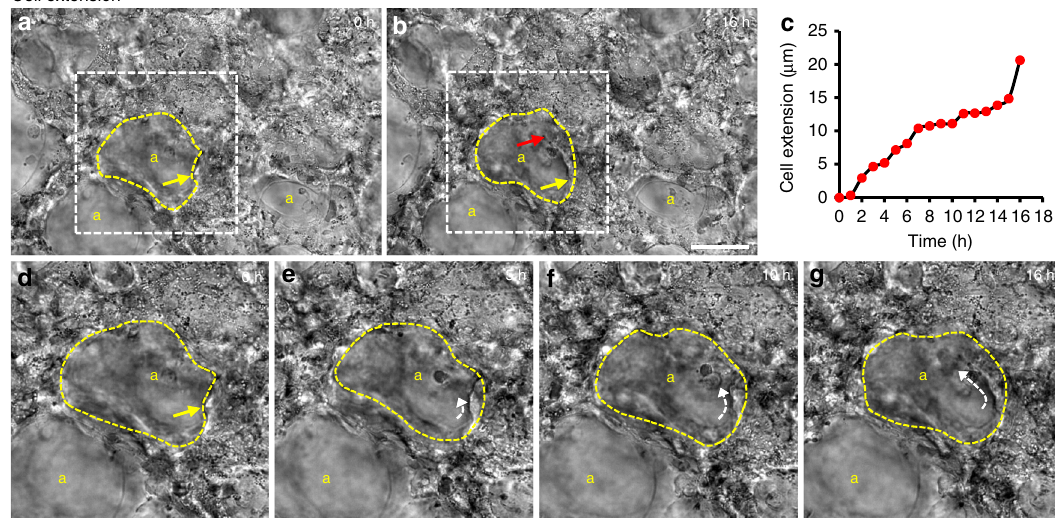
Fig. 5 Cell extension during postnatal alveologenesis. Bright fi eld still images from P4 PCLS time-lapse video (Supplementary movie 10) at 0 ( a , d ), 5 ( e ), 10 ( f ) and 16 ( b , g ) hours showing cell extension along an alveolar wall (dashed yellow line in a , b , d – g ); yellow ‘ a ’ indicates airspaces, yellow arrow indicates cell position at 0 h ( a , d ), red arrow indicates the fi nal cell position ( b ). Measurement of cell extension during 16 h of time-lapse imaging ( c ). Enlargement of white boxed areas in a and b show the extending cell (white dashed arrow) during a 16 h video ( e – g ). Scale bar = 50 µ